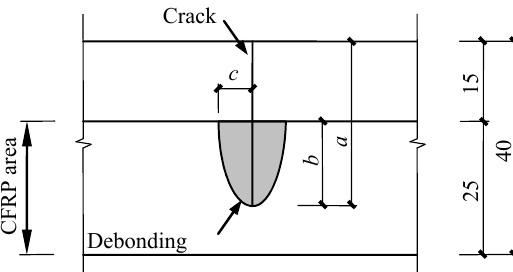
Figure 13. ( a ) Typical finite element model; ( b ) Detailed mesh in the debonding zone; ( c ) Detailed mesh at the crack tip.